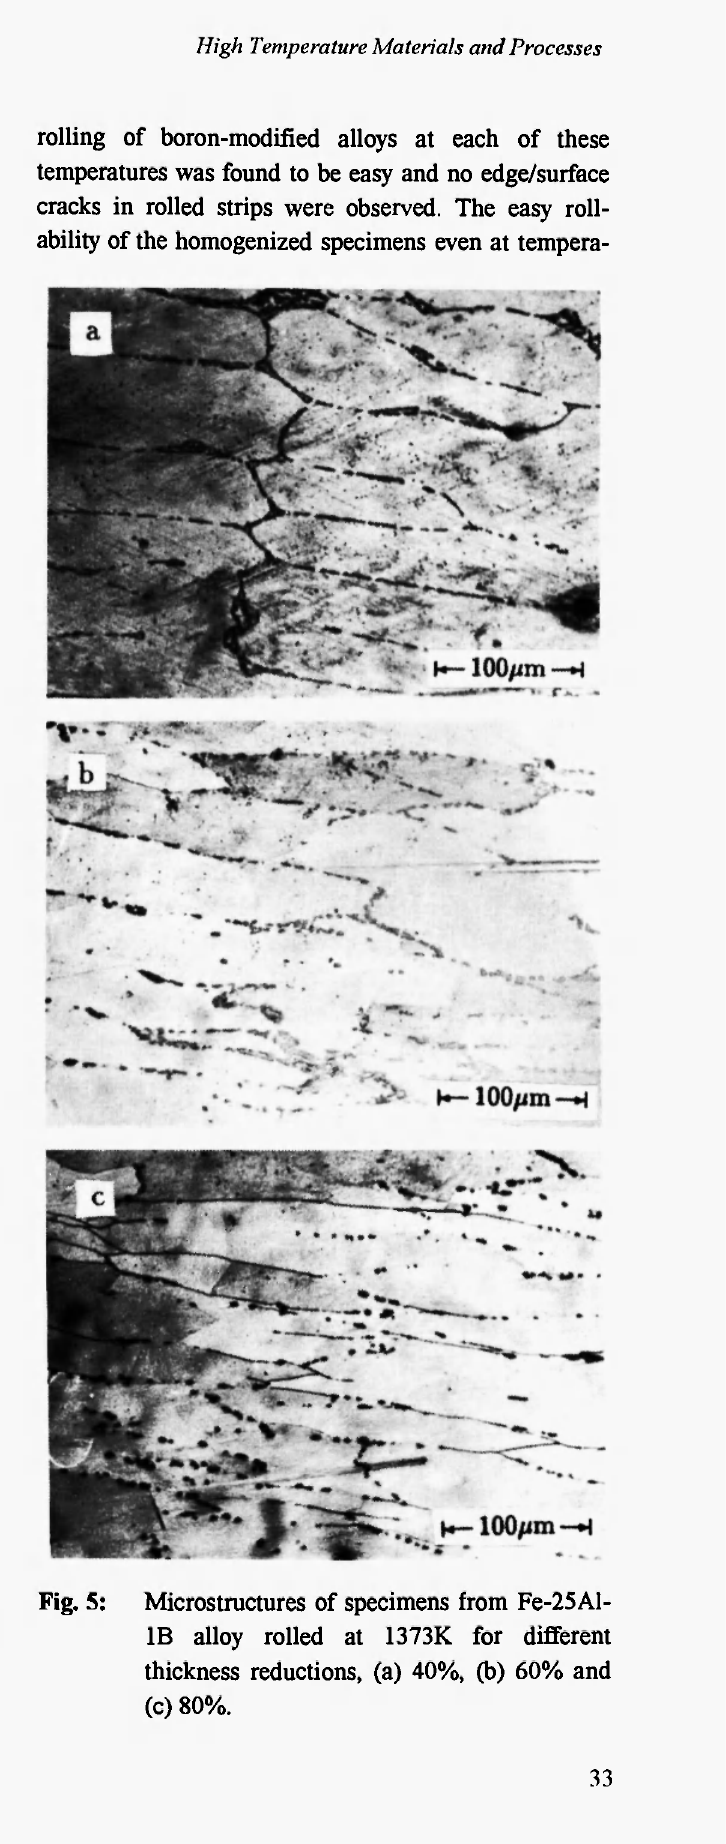
Fig. 5: Microstructures of specimens from Fe-25A1- 1B alloy rolled at 1373K for different thickness reductions, (a) 40%, (b) 60% and (c)